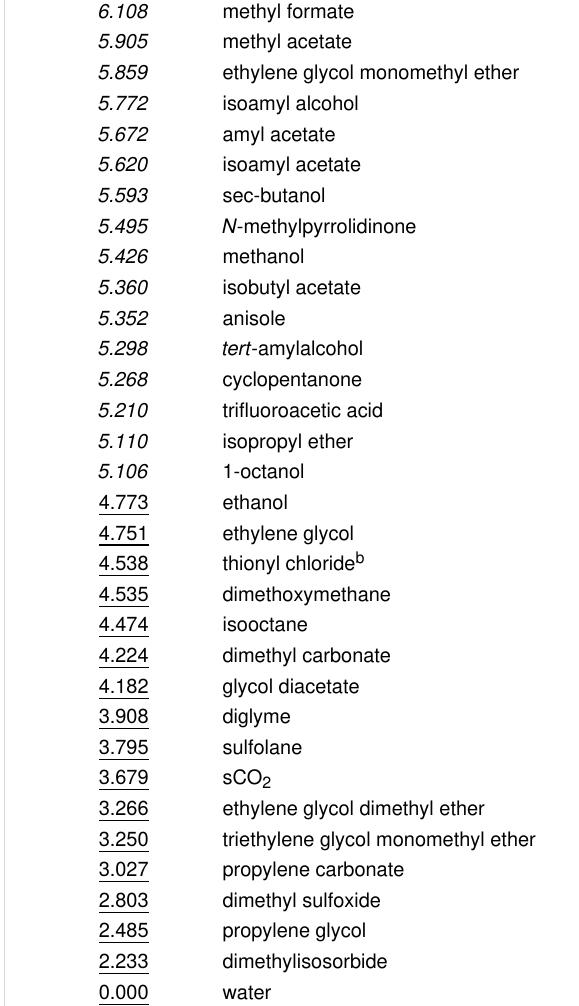
Table 1: Revised summary of overall solvent index (OSI) for various organic solvents used in the pharmaceutical industry.